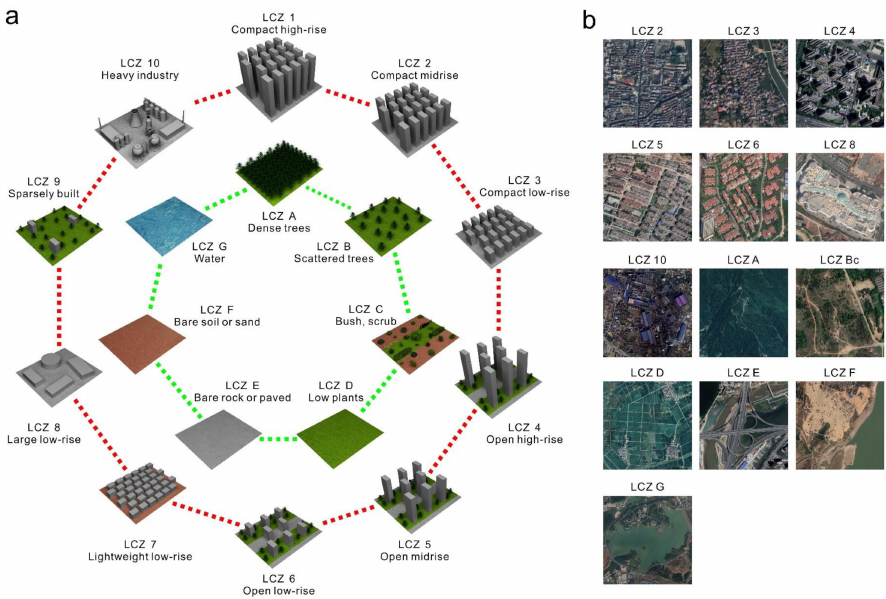
Figure 2. ( a ) Standard local climate zone (LCZ) scheme modified from Stewart and Oke [4]. ( b ) Google Earth images of typical samples of the LCZs in